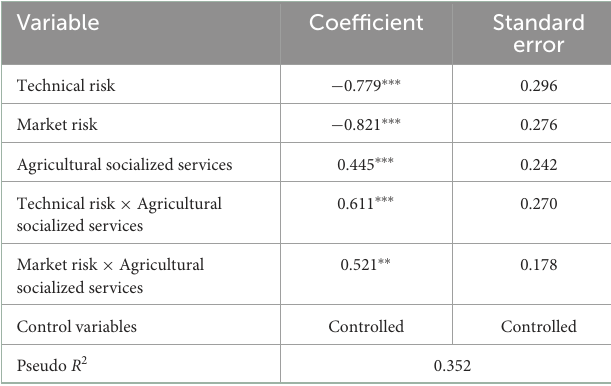
TABLE 7 Robustness test estimation